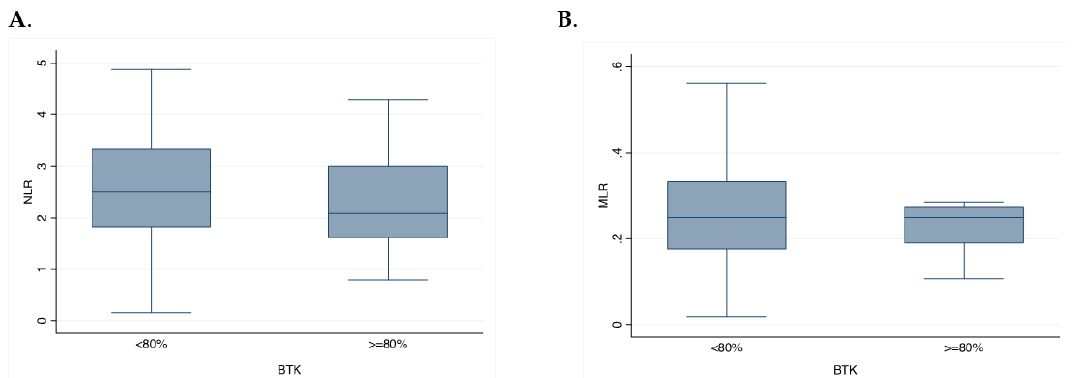
Figure 5. Exploratory analysis. 5A . Box representing the association of neutrophils-to-lymphocytes (NLR) with BTK intensity 3. 5B . Box representing the association of monocytes-to-lymphocytes (MLR) with BTK intensity 3.